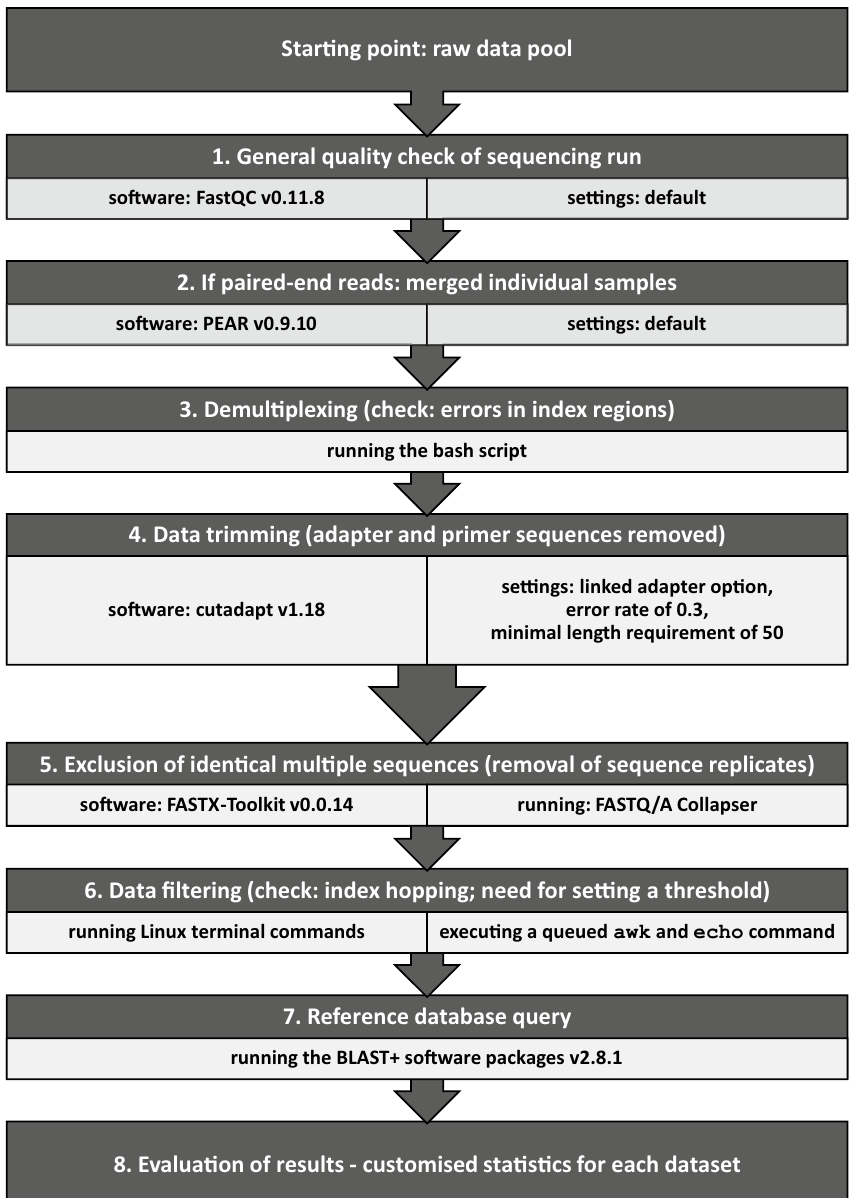
Figure 2. Diagram of the eight data processing steps for the evaluation of the applied nested metabarcoding